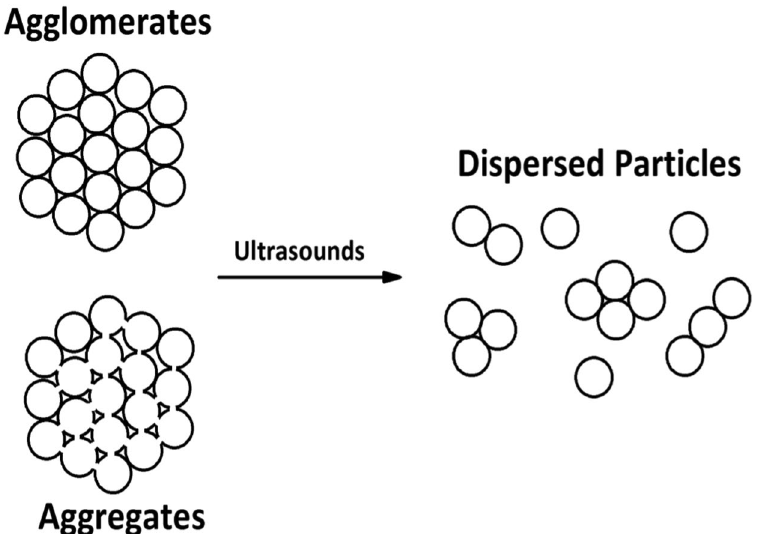
Figure 6. Possible formation mechanism for nLTO particles 48